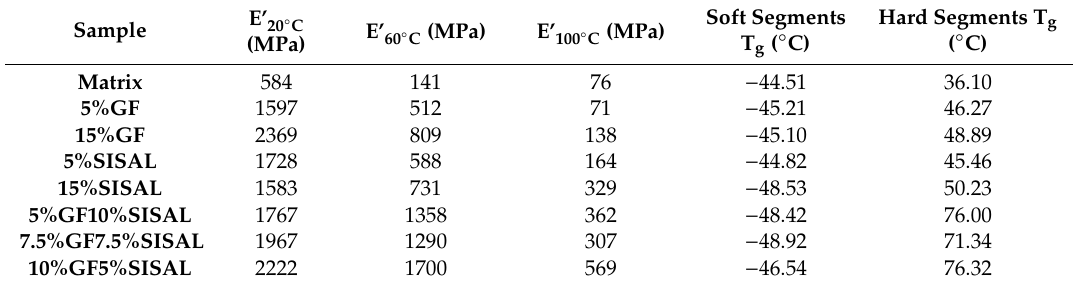
Table 3. Storage modulus at di ff erent temperatures and glass transition (T g ) of hard and soft segments.